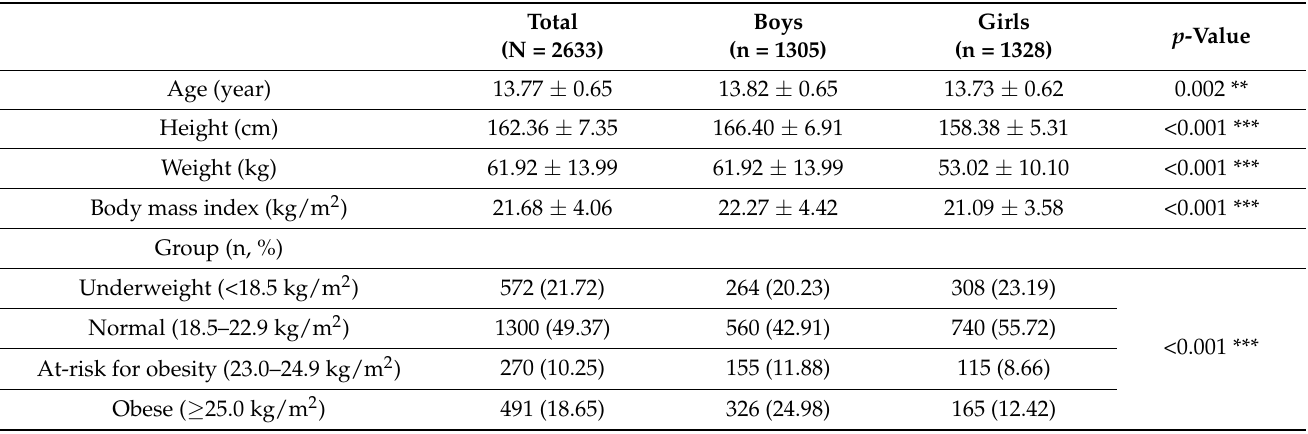
Table 1. Physical characteristics by